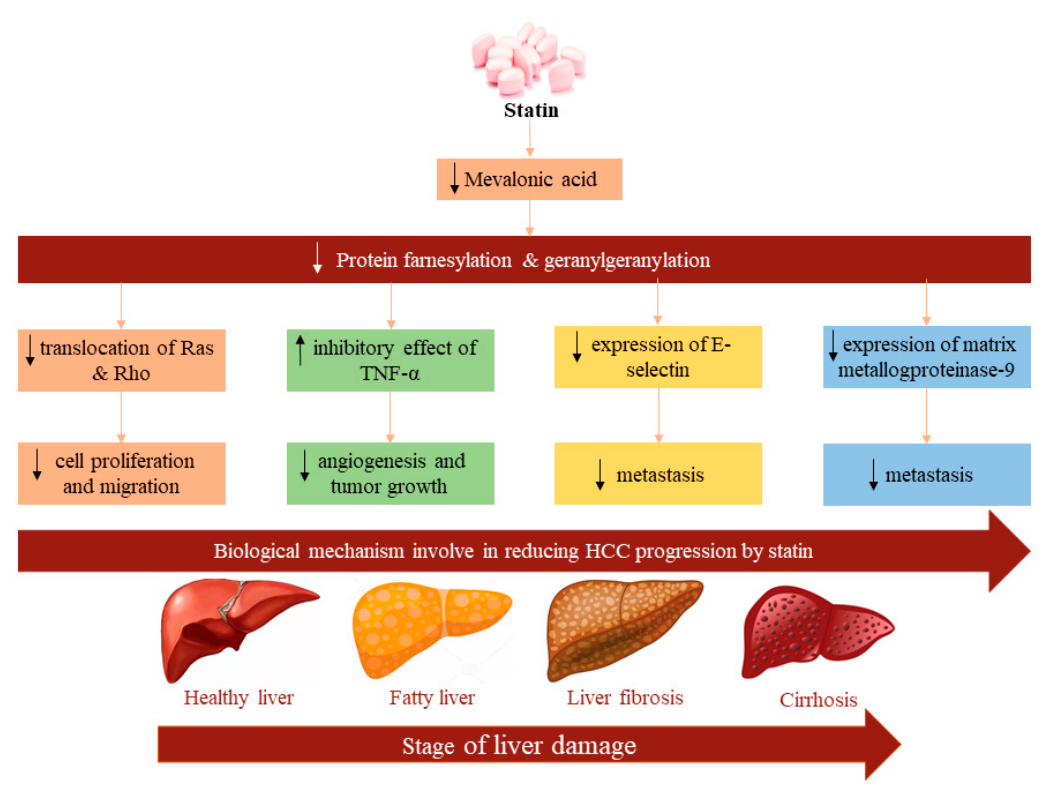
Figure 6. Mechanism of statins to prevent hepatocellular carcinoma (HCC).